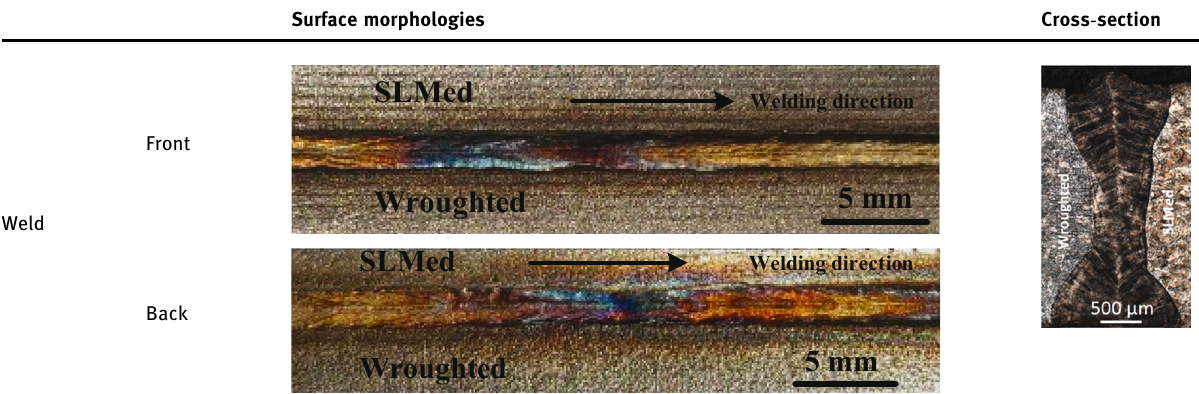
Table 3: Surface morphologies of laser - welded seam in front and back views and the cross - section of joints Surface